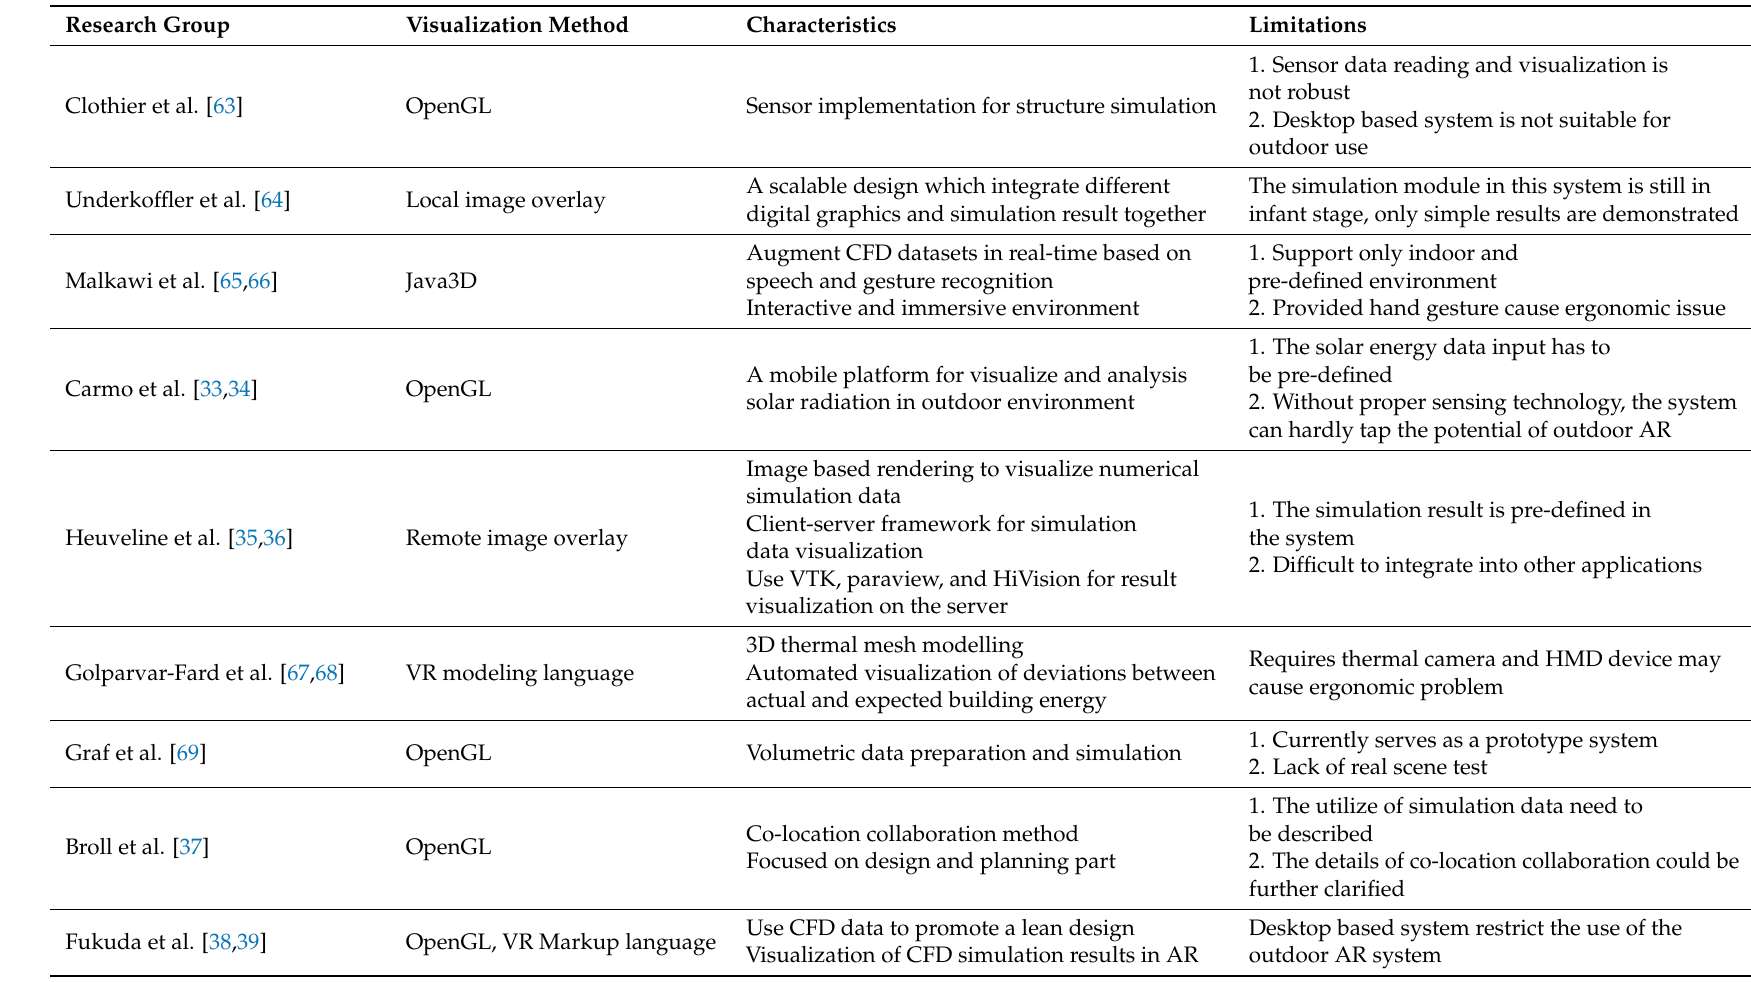
Table 3. Characteristics and limitations of research in civil and urban